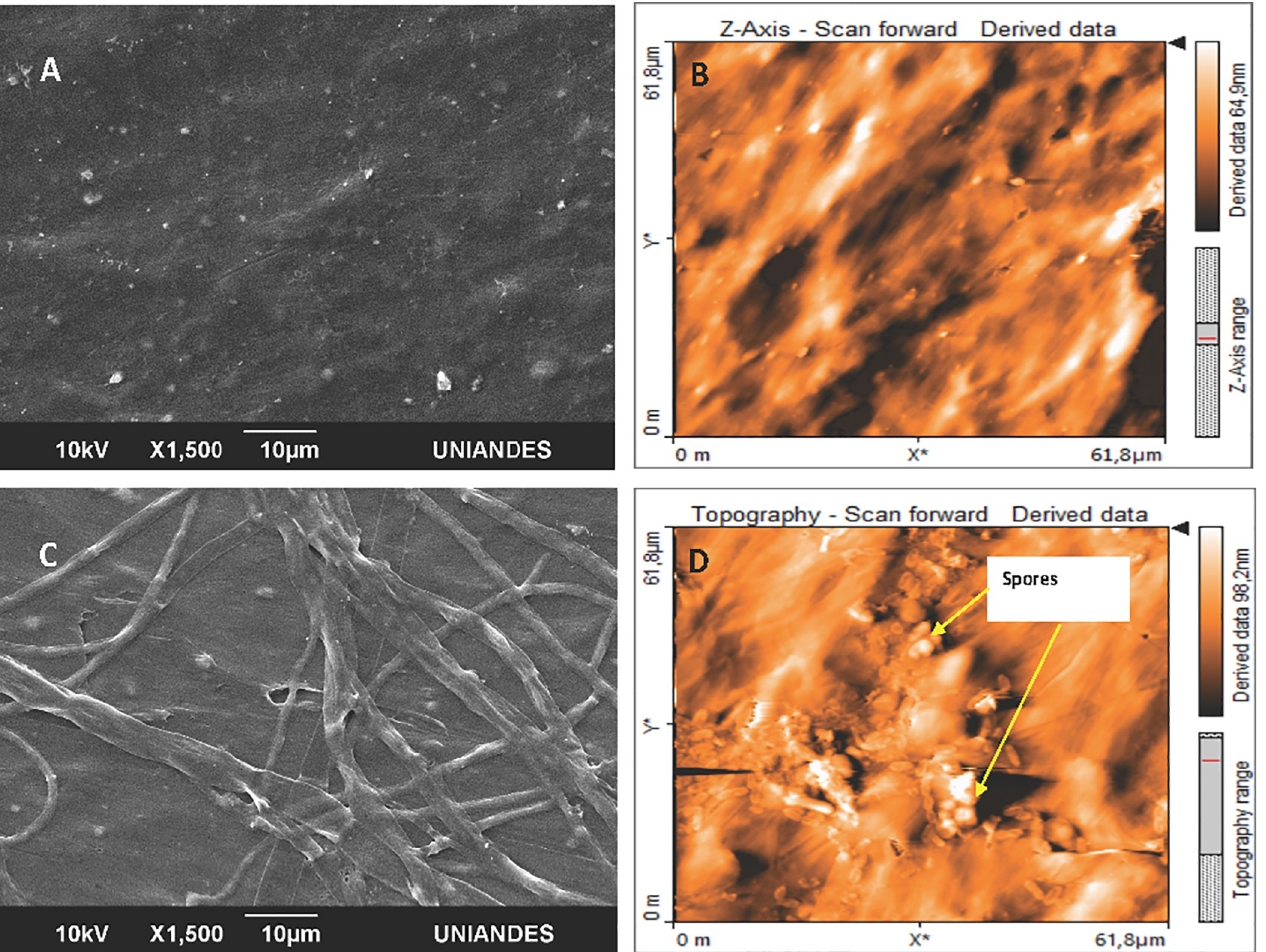
Fig 2. SEM (A, C) and AFM (B, D) microscopic images. (A, B) Pristine LDPE oxo . (C) LDPE oxo SEM image after 75 days in microcosm. (D) LDPE oxo AFM image after 75 days in microcosm.